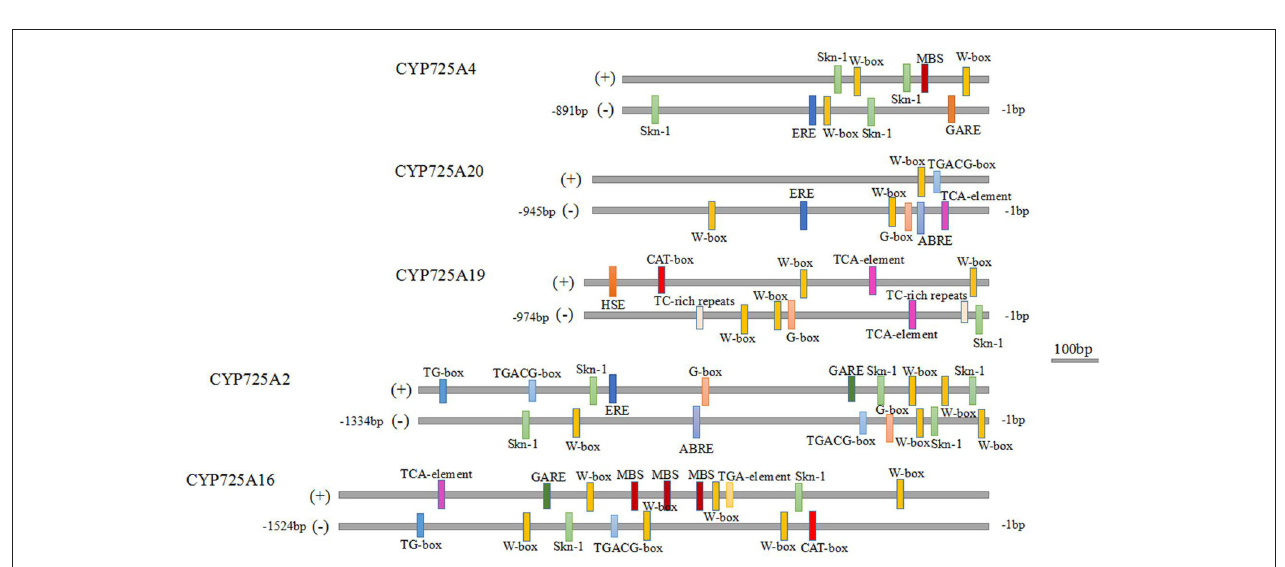
FIGURE 7 | Comparisons of the expression profiles of 15 novel CYP725 genes in different 5-year-old Taxus species, including T. chinensis, T. cuspidate, and T. Media . The bars represent the standard deviation ( n = 3).